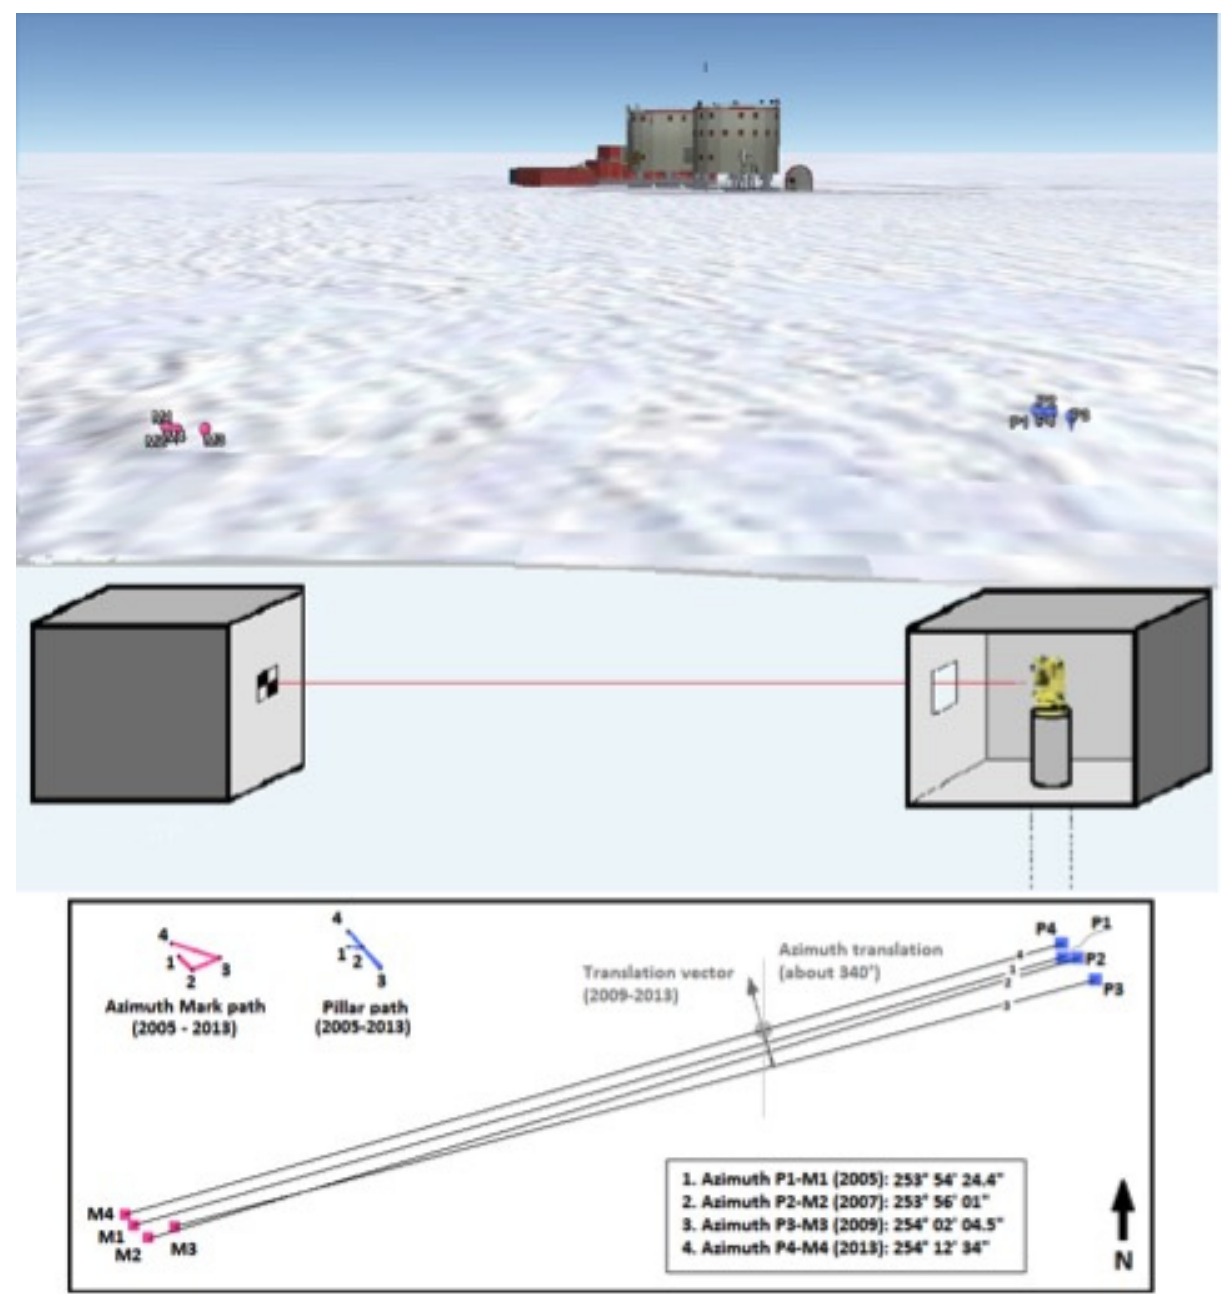
Figure 5. Graphic rendering (from Google Earth TM) of Concordia Station and the evolution of the geographic positions for the pillar (P1 to P4) and azimuth mark (M1 to M4), in successive GNSS surveys from 2005 to 2013, together with a schematic sketch of the current configuration of the whole observatory (middle figure). Both shelters are completely embedded into the ice at present. Each azimuth line is reported from 1 to 4 (bottom graph), according to the year of survey. A translation along the years in two opposite directions and slight rotations are reported also in the text. In the left side, the complete path followed by the azimuth mark position along the years resembles a nearly close